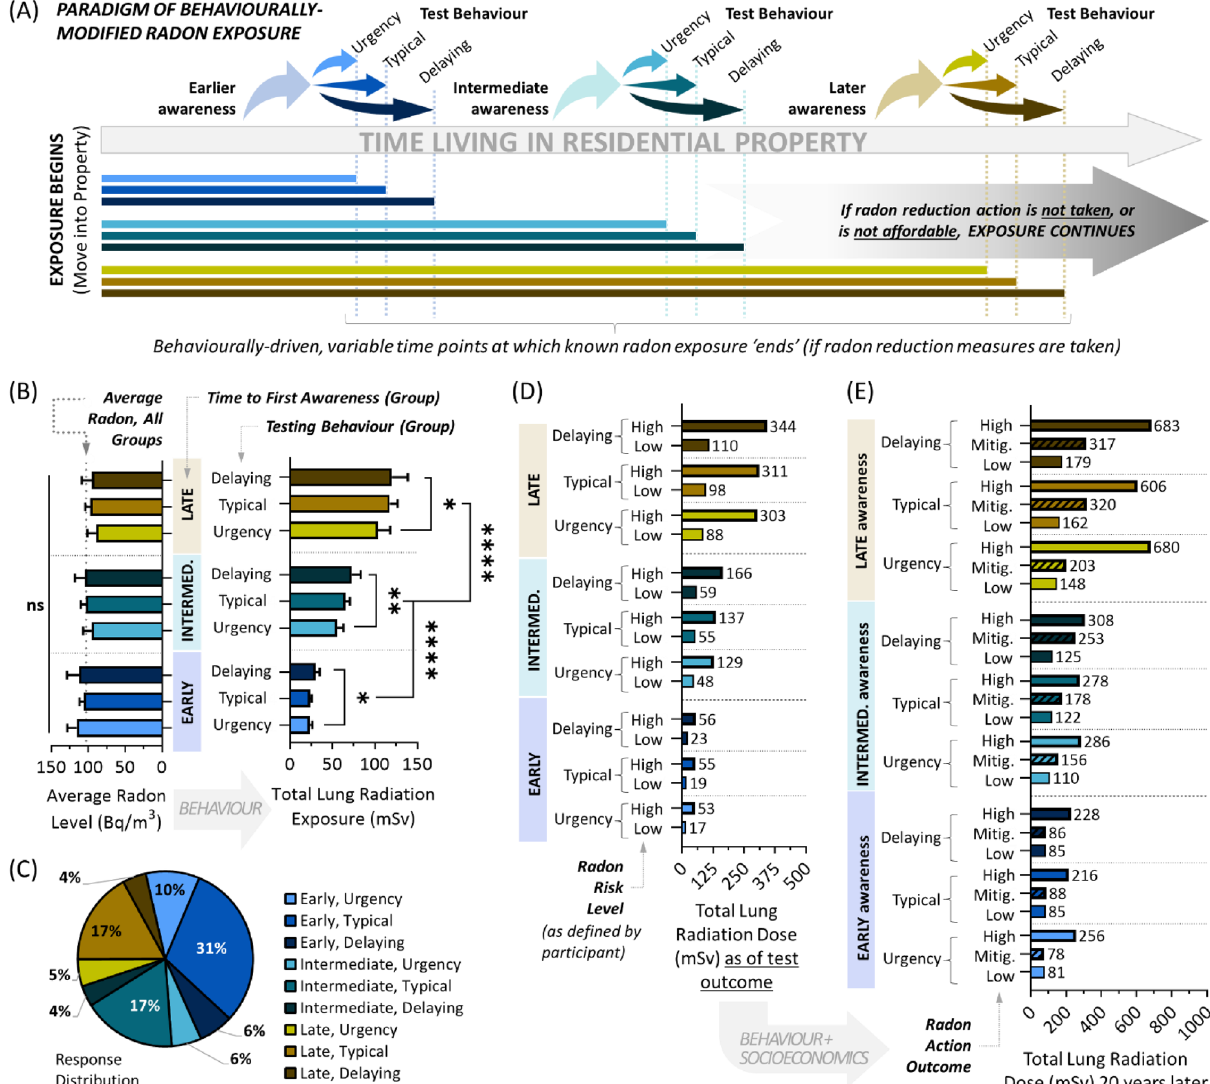
Figure 7. A paradigm for radiation exposure from radon as a function of integrated behaviours over time. ( A ) A schematic for all events and behaviours that modify doses of lung radiation from residential radon, independent of a property radon level. ( B ) The geometric mean property radon level (Bq/m 3 ) and total lung radiation dose (mSv) experienced by nine indicated groups delineated by both period of radon awareness and radon testing behaviour. Statistical comparisons are Mann–Whitney pairwise nonparametric t-tests. ****p < 0.0001; **p < 0.01; *p < 0.05; ns = p > 0.05. ( C ) Relative distribution of the nine groups indicated in ( B ) within the participant cohort. ( D ) Actual geometric mean total lung radiation dose (mSv) experienced by the groups outlined in ( B ) at the time property radon level outcomes were known, as a function of risk level (interpreted by individual). ( E ) Projected geometric mean total lung radiation dose (mSv) experienced by the groups outlined in ( D ) 20 years later, separating those who interpreted their radon risk as high/unsafe into those who mitigated their property (‘mitig.’) or did not (‘high’). Figures were prepared using Excel and GraphPad Prism 9.1.1 (225) (www. graph pad.